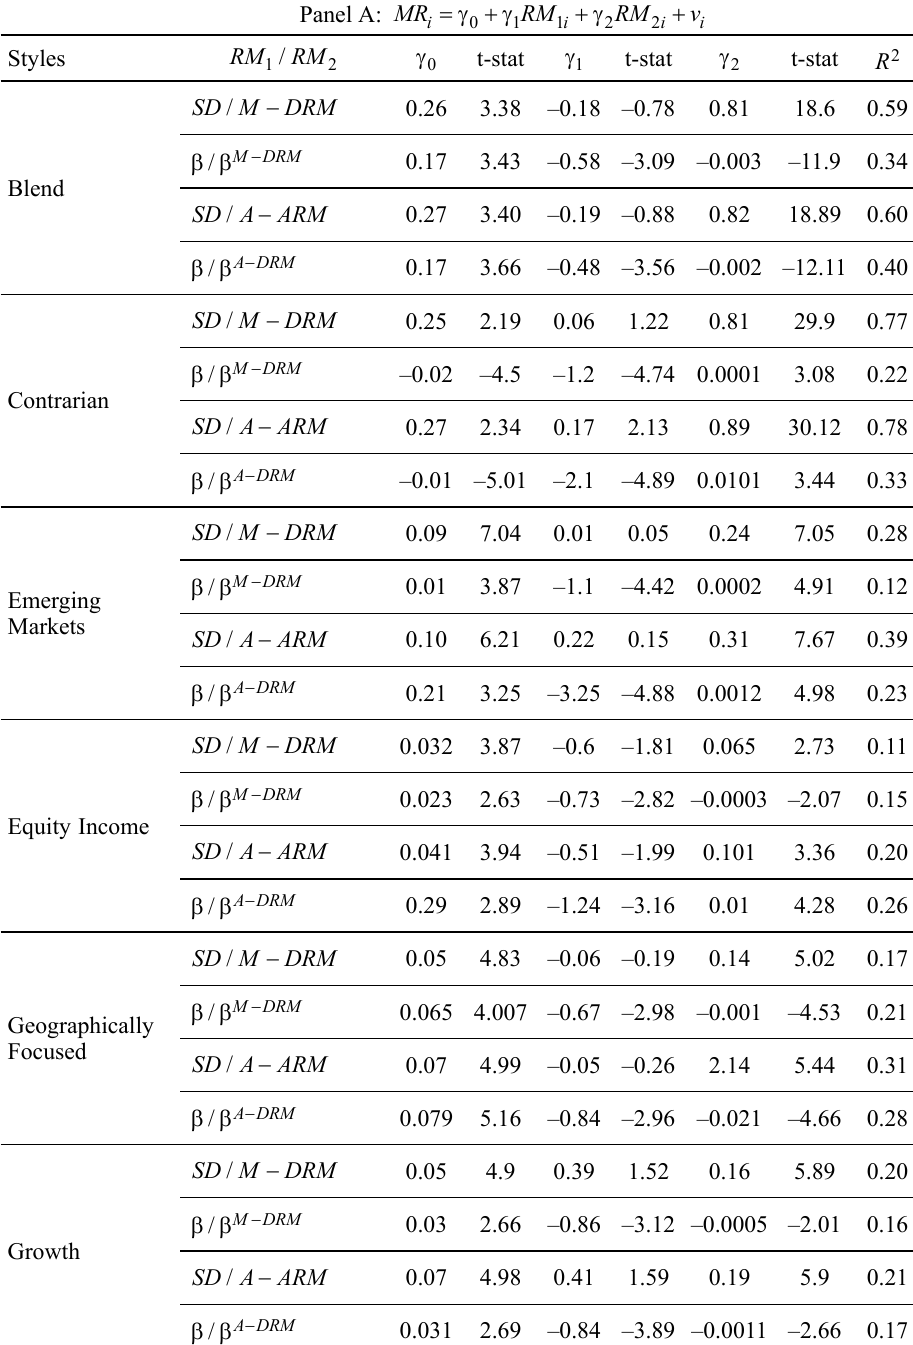
Table 6. Management styles: multiple regression